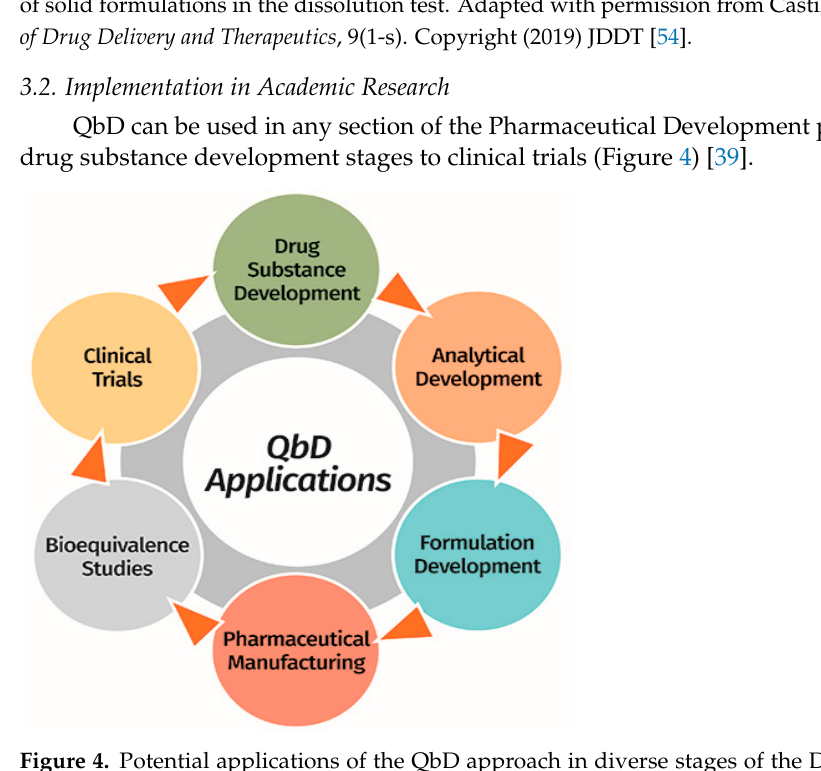
Figure 3. Example of a Design of Experiments carried out in the Academy to assess the perfor- mance of solid formulations in the dissolution test. Adapted with permission from Castillo, L. et al. Journal of Drug Delivery and Therapeutics , 9(1-s). Copyright (2019) JDDT [54].